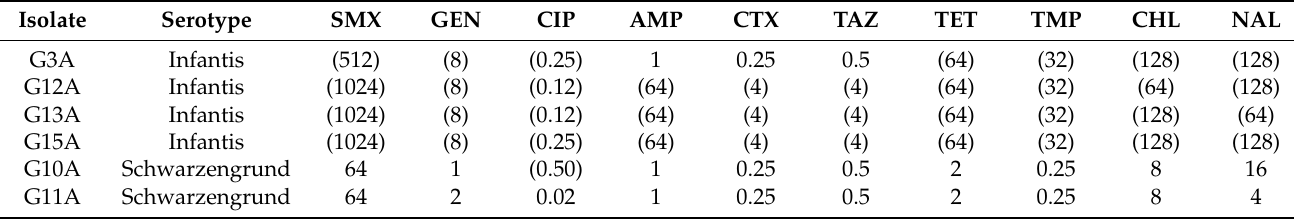
Table 1. Minimum Inhibitory Concentration values ( µ g/mL) for various antibiotics against strains of Salmonella Infantis and Salmonella Schwarzengrund.